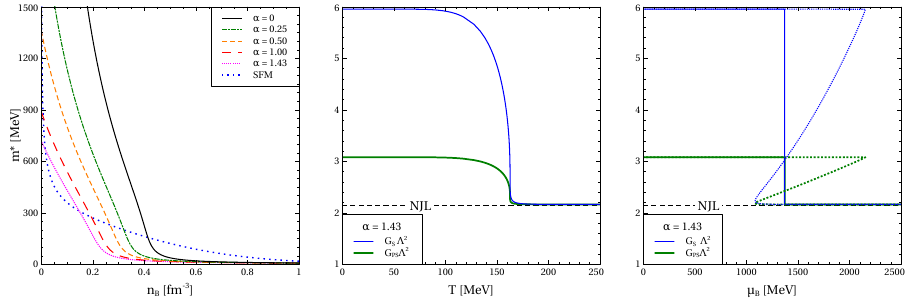
Figure 1. E ff ective quark mass m ∗ as function of baryon density n B (left panel), scaled e ff ective scalar G S Λ 2 and pseudoscalar G PS Λ 2 couplings as functions of temperature T at µ B = 0 (middle panel) and baryonic chemical potential µ B at T = 0 (right panel). The blue dotted line on the left panel is obtained within the SFM with α SFM = 0 . 39 fm − 3 [11]. Dashed lines on the middle and right panels represent the NJL value G Λ 2 = 2 . 14 [12]. Dotted curves on the middle panel indicate the unstable parts that are removed by applying the Maxwell construction. Calculations are performed for symmetric quark matter, G V = G D = 0, α specified in the legend and the rest of the model parameters from Table 1.